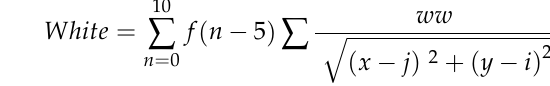
Figure 8. Schematic diagram of problem encountered during the actual scanning process.